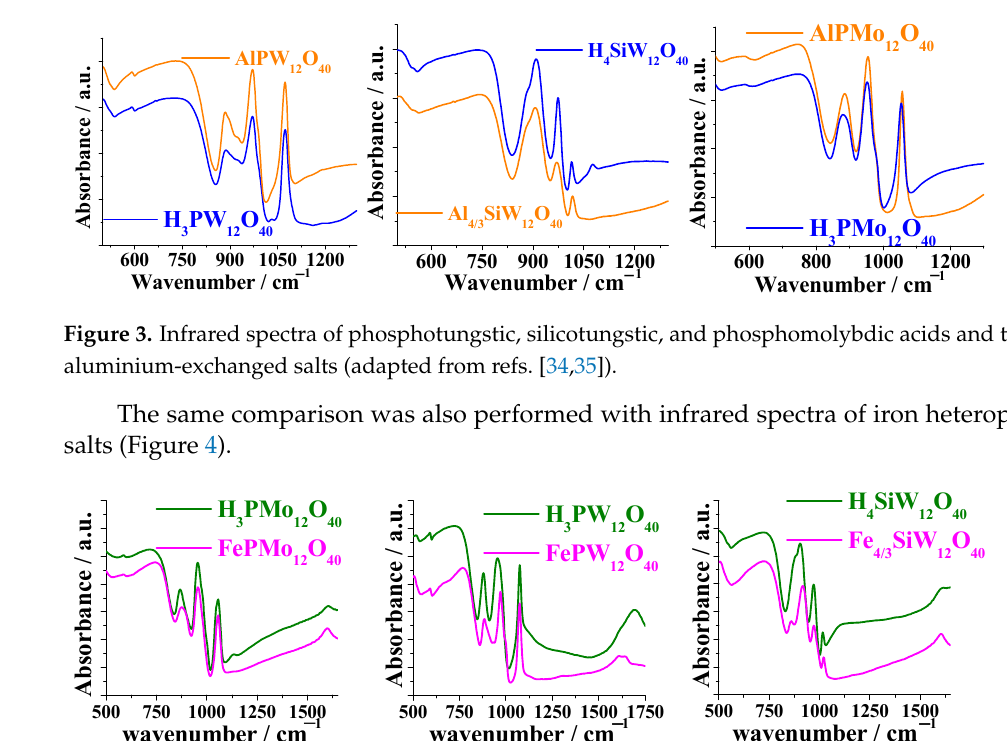
Figure 2. Infrared spectra of metal-exchanged silicotungstic acid salts (adapted from ref. [27]).